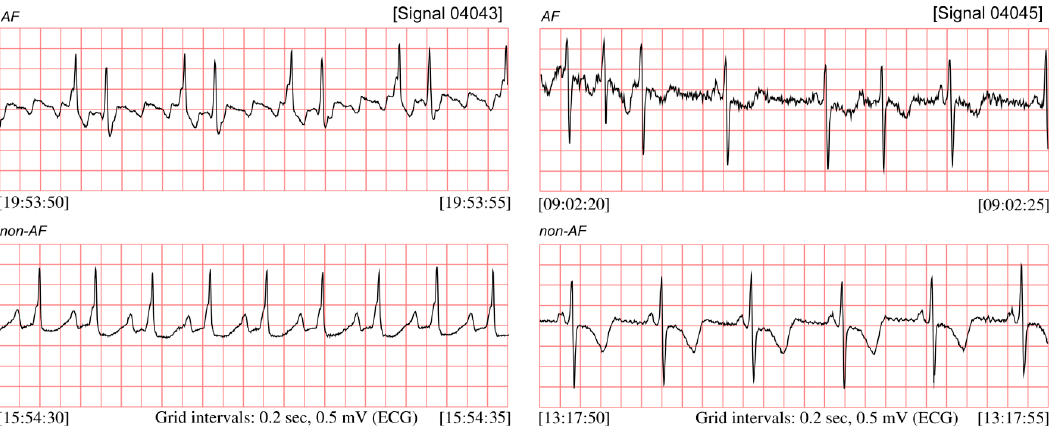
Figure 1. ECG signals (04043 and 04045) taken from the MIT-BIH AF database, with recognized segments of atrial fibrillation and the non-AF ones.